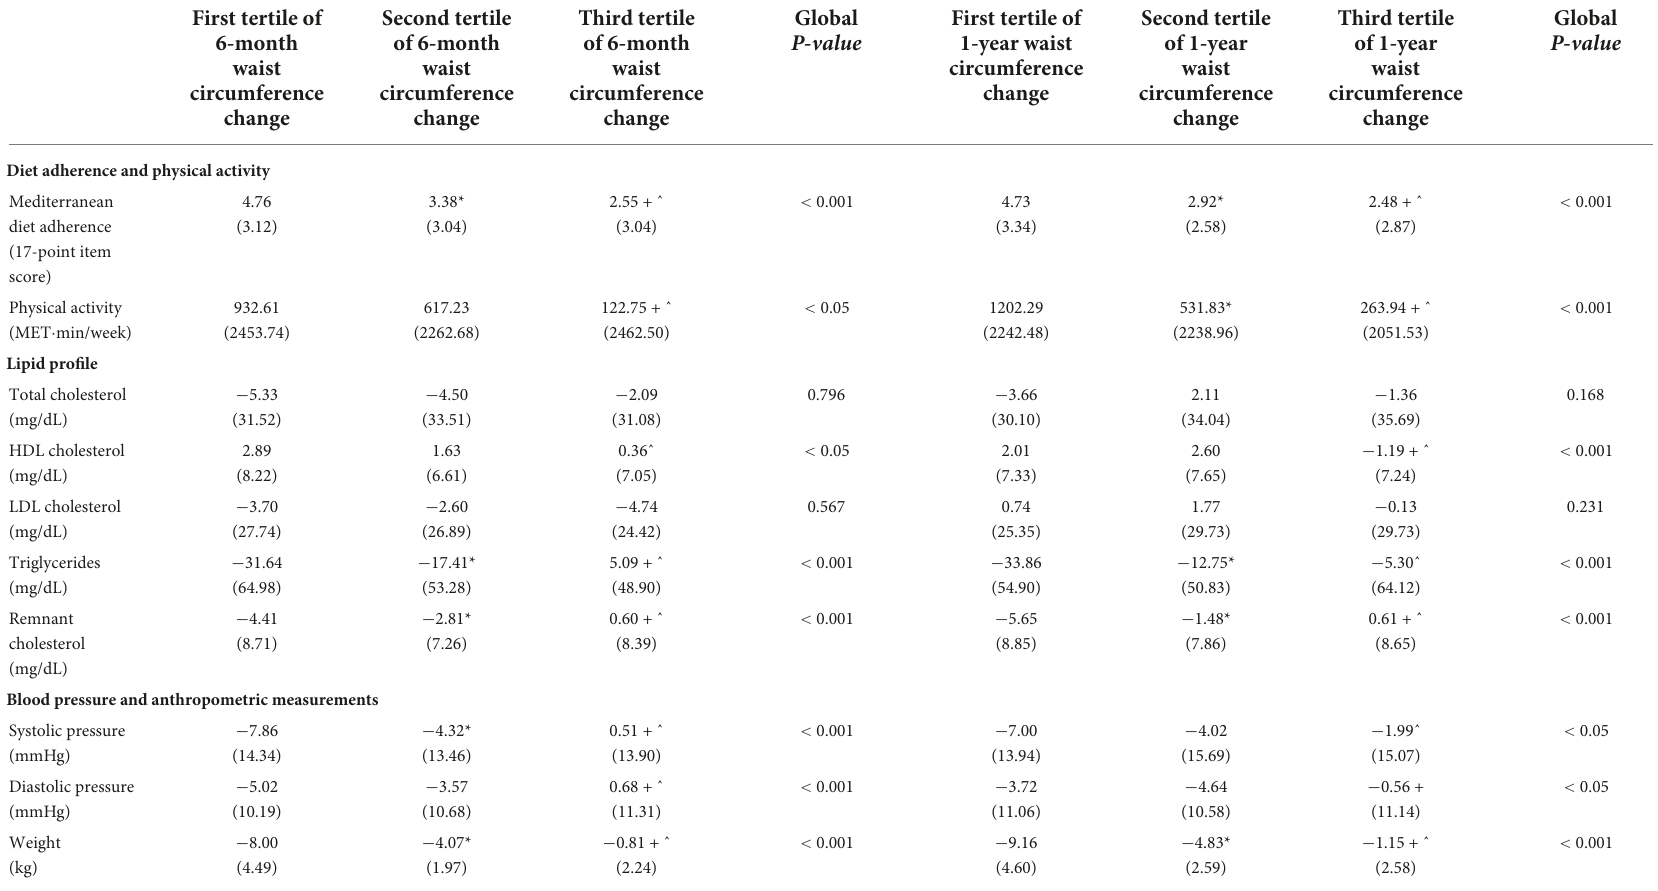
TABLE 4 Tertiles of waist circumference change (mean, standard deviation, and their comparison) adjusted for weight and baseline value of the participants on the 17-item questionnaire, physical activity, biomarkers and anthropometric measurements, lipid profile, carbohydrate metabolism, and